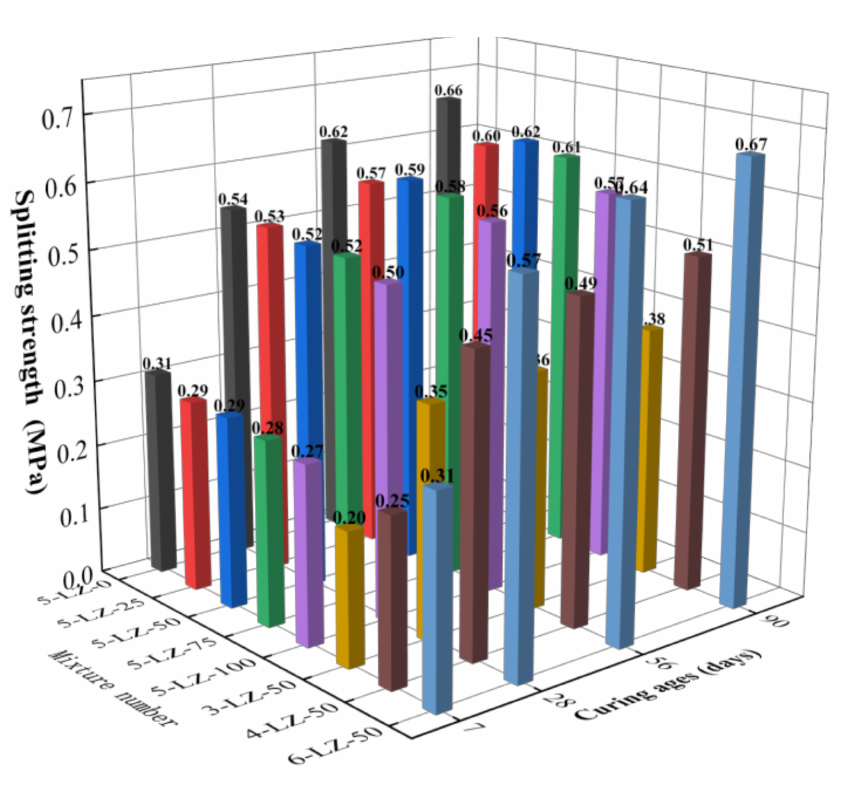
Figure 7. Results of the splitting test for different